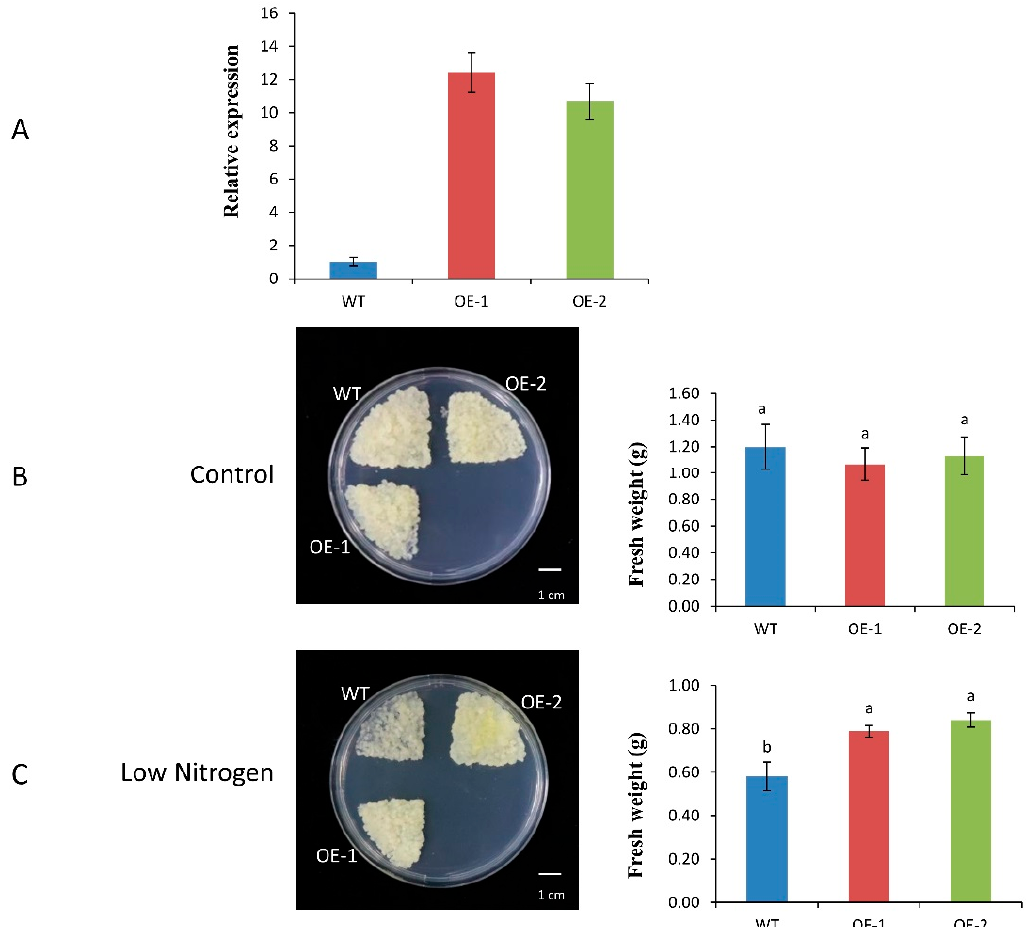
Figure 7. Influence of overexpression by MdNPF6.5 on tolerance by apple calli to low-nitrogen supply. ( A ) Quantitative real time RT-PCR of samples from WT and MdNPF6.5 -overexpressors. ( B ) Assay of low-nitrogen tolerance by WT and MdNPF6.5 -overexpressors. Calli were transferred to MS medium or low-nitrogen medium, and photographed at 20 days after treatment began. ( C ) Comparison of fresh weights from WT and MdNPF6.5 -overexpressors in response to low nitrogen. Values are means ± standard deviation. Different letters on the bars indicate significant differences ( p < 0.05), based on Tukey’s multiple range tests.